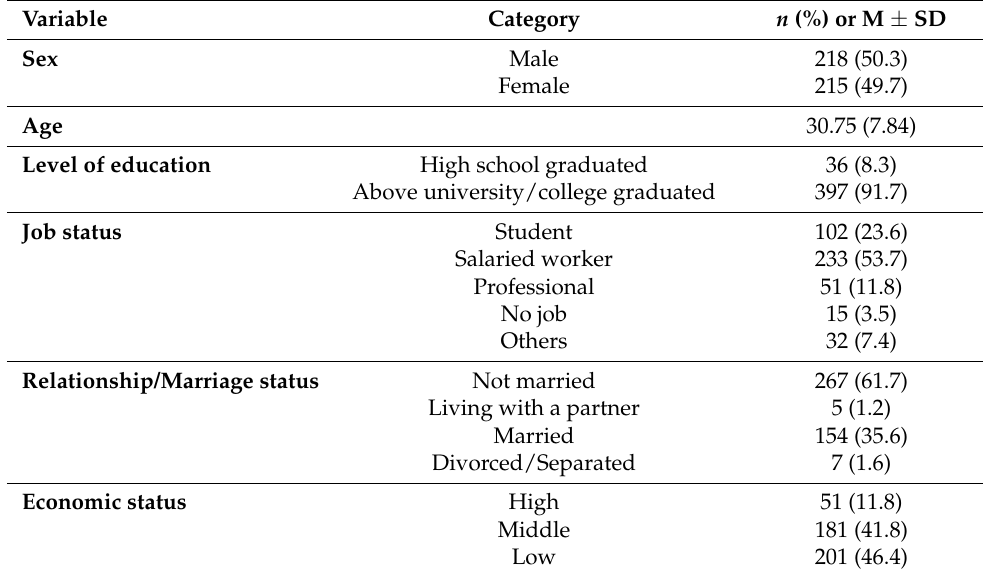
Table 1. Participants’ sociodemographic characteristics ( n = 433).